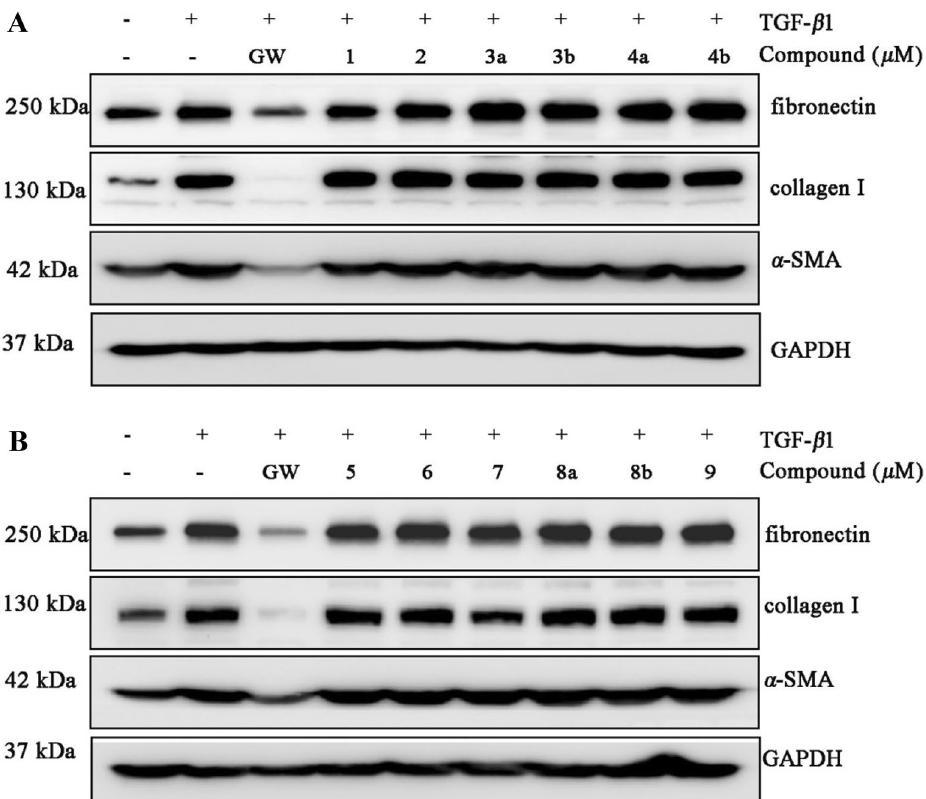
Fig. 7 Western blot analysis showing that 1 and 7 protect against TGF- β 1-mediated renal fibrosis. NRK-52e cells were incubated with TGF- β 1 (10 ng/mL) for 48 h in the absence or presence of the compounds (40 μM). Cell lysates were immunoblotted with antibod-